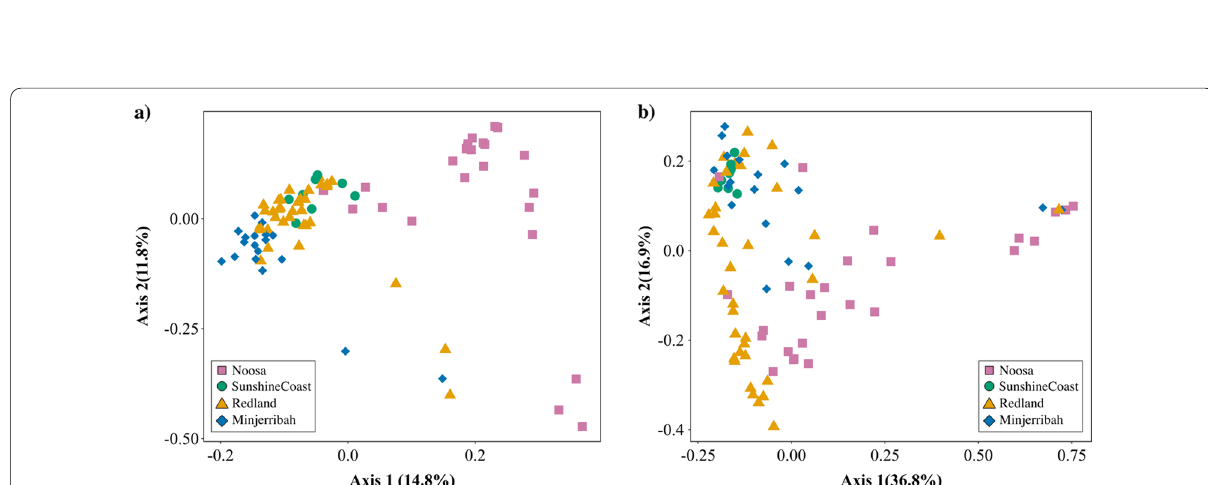
Fig. 2 Relevant abundance of bacterial phyla for each individual koala ( n Firmicutes and Proteobacteria